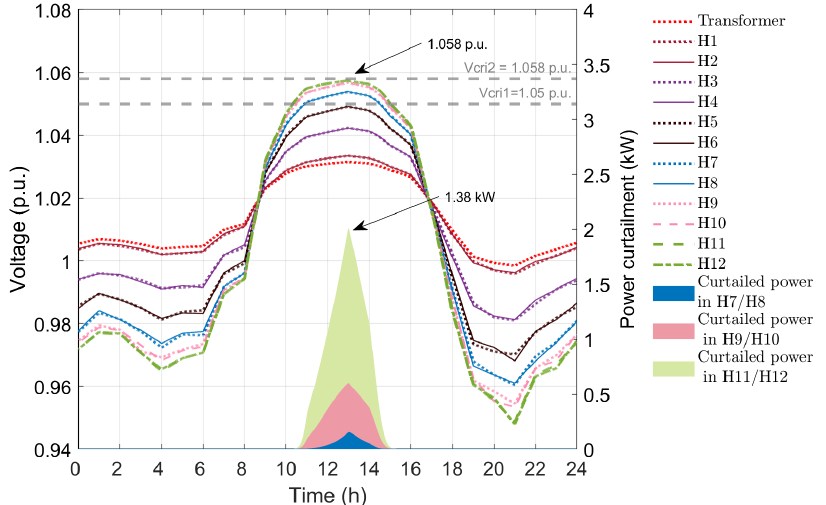
Figure 14. Voltage profile of twelve houses (House 1 to House 12) and curtailed power in exponential droop-based APC method using